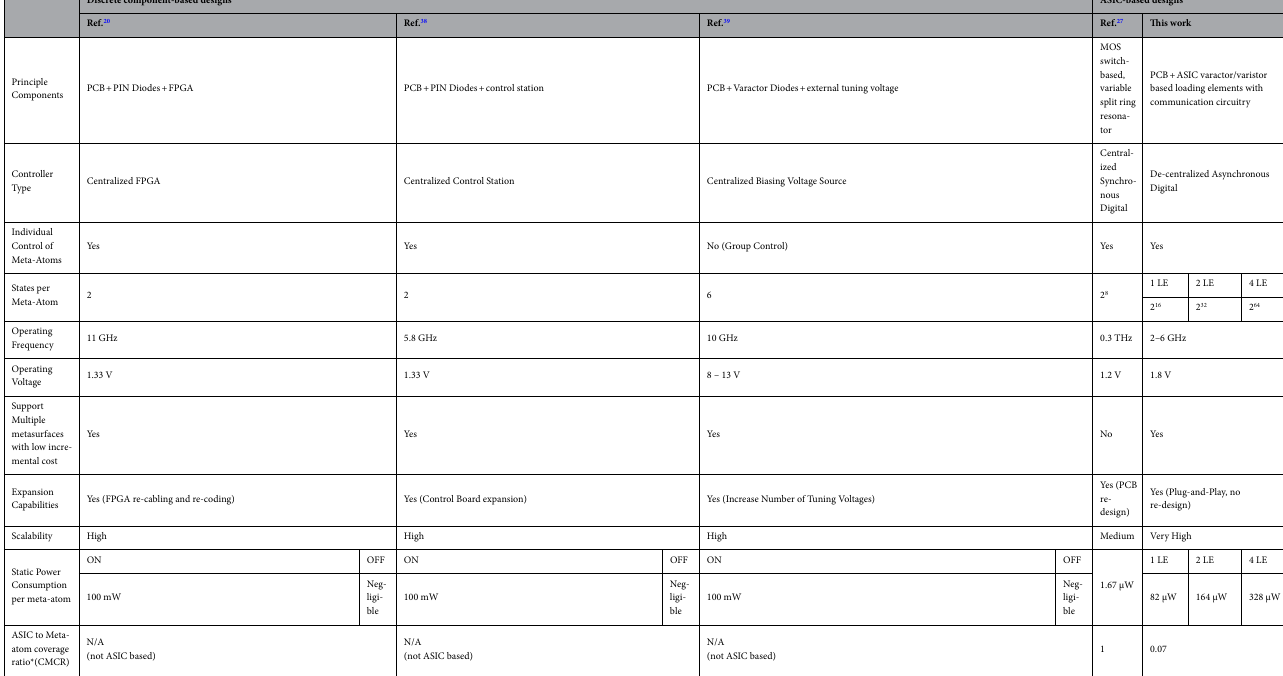
Table 2. Comparison with other tunable and programmable metasurface enabling circuits indicating the strengths and weaknesses of all approaches to give the reader insight of the best approach suited for various applications. *CMCR is defined in